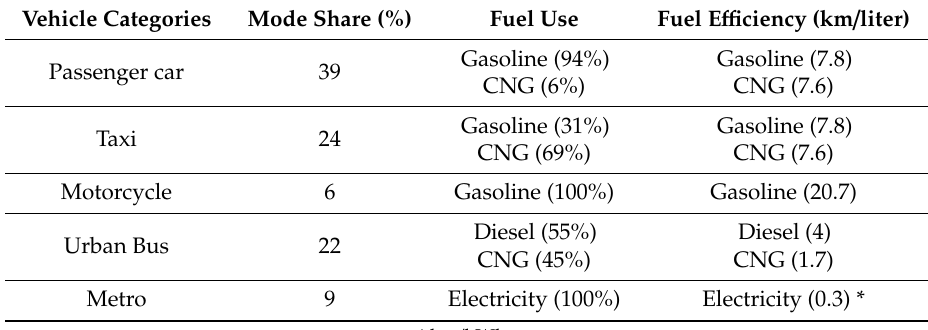
Table 2. Modal splits, fuel use and e ffi ciency in the urban transport sector in Tehran [52].